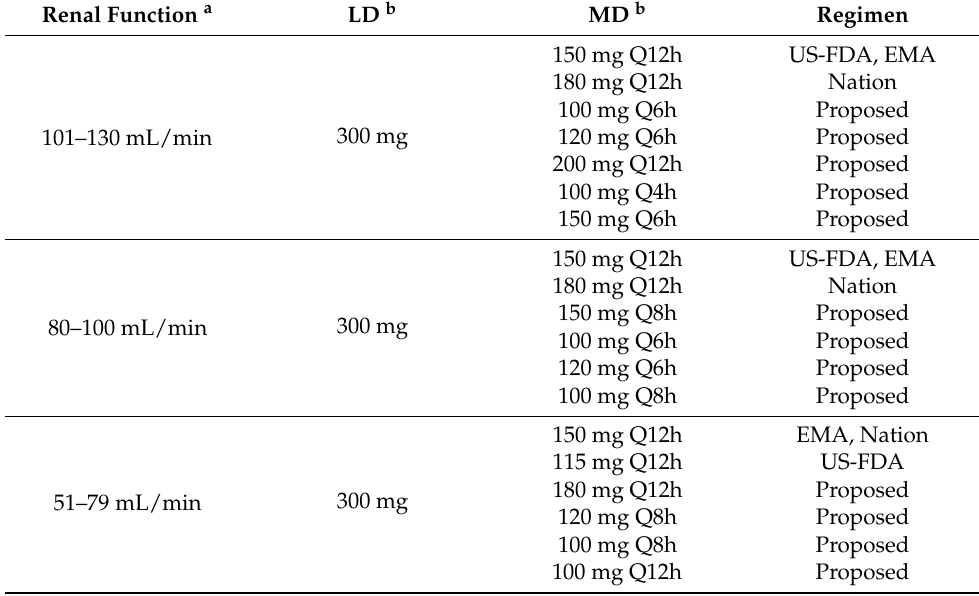
Table 2. Tested dosing